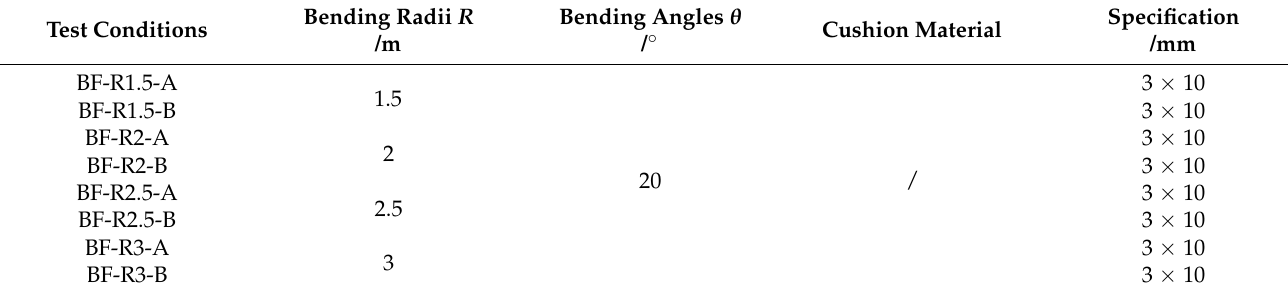
Table 4. Bending test conditions of CFRP cables.